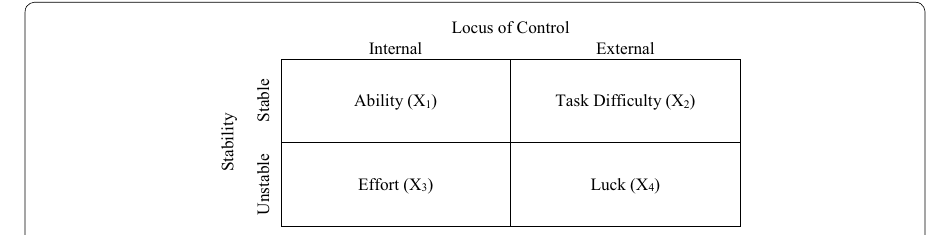
Fig. 1 Four attributions that explain academic outcomes (McNabb 2003, p.